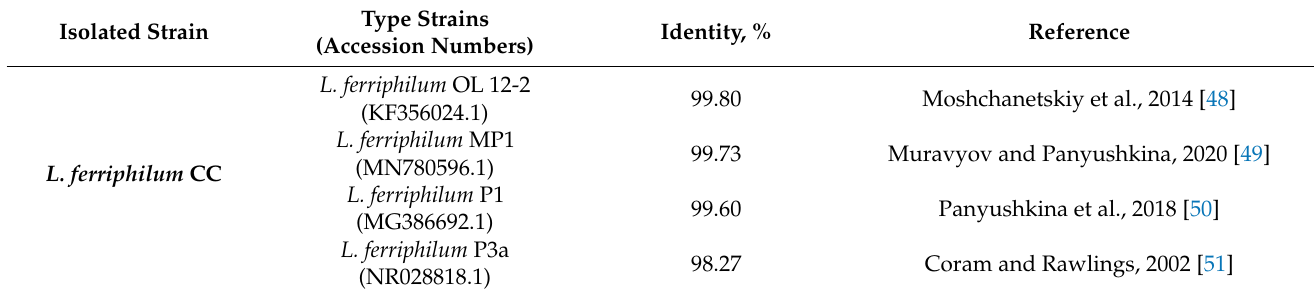
Table 2. Identity of 16S rRNA of isolated Leptospirillum sp. CC with other L. ferriphilum